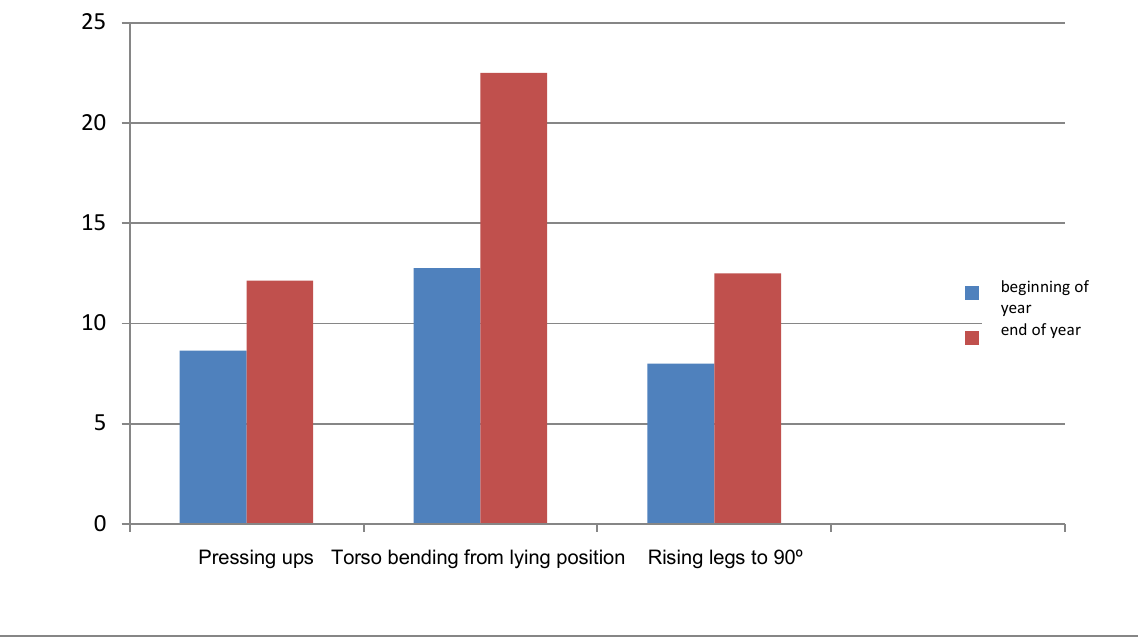
Fig.1. Mean indicators of girl students’ speed-power qualities at the beginning and at the end of academic year Besides, in both groups mobility of backbone increased (test for flexibility). It reflected in statistically confident increase of torso bending, in average by 3.5